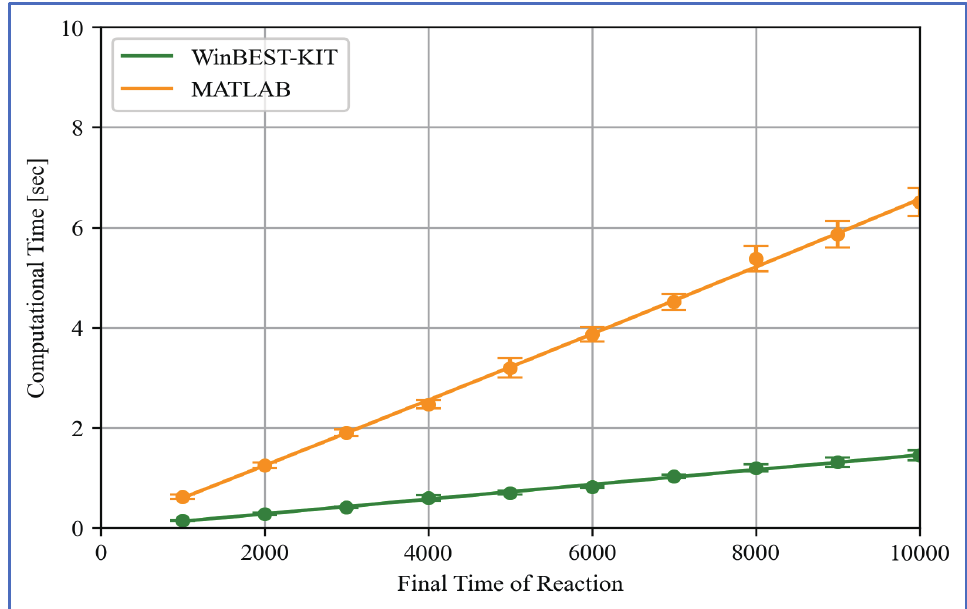
Figure 13. Comparison results of the computational time for the published SBML model as mentioned in Section 5.3. Each measurement point is the mean value of 100 times calculations and the error bar shows its standard deviation.